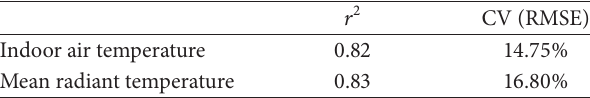
Table 6: Correlation coefficient